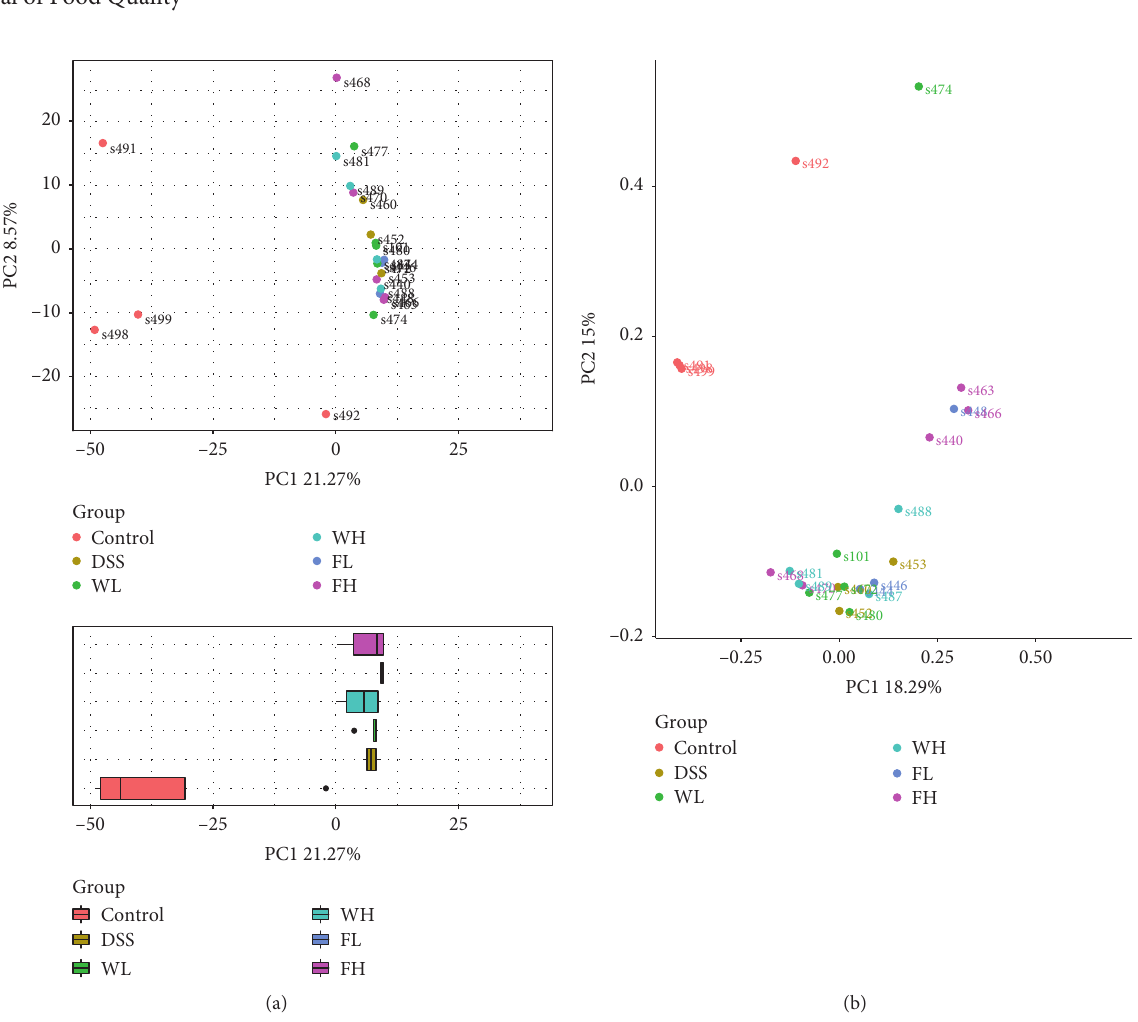
Figure 4: The variation of fecal microbiota based on 16S rRNA gene sequences among different treatment group samples including principal component analysis (PCA) (a) and principal coordinates analysis (PCoA)